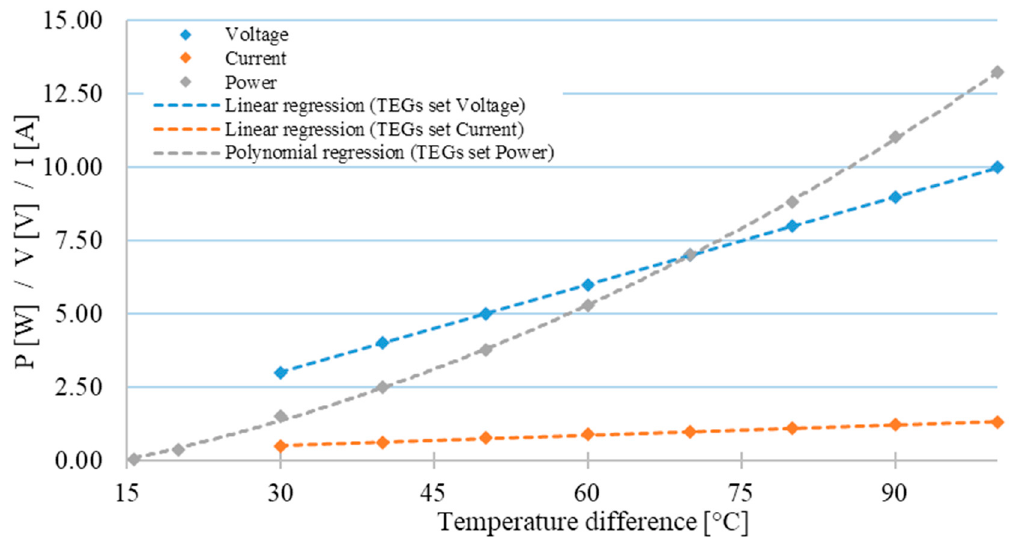
Figure 11. inbC1-127.08HTS TEGs set rated electrical parameters. Reprint with permission [54]; 2019, WAtronix, Inc.